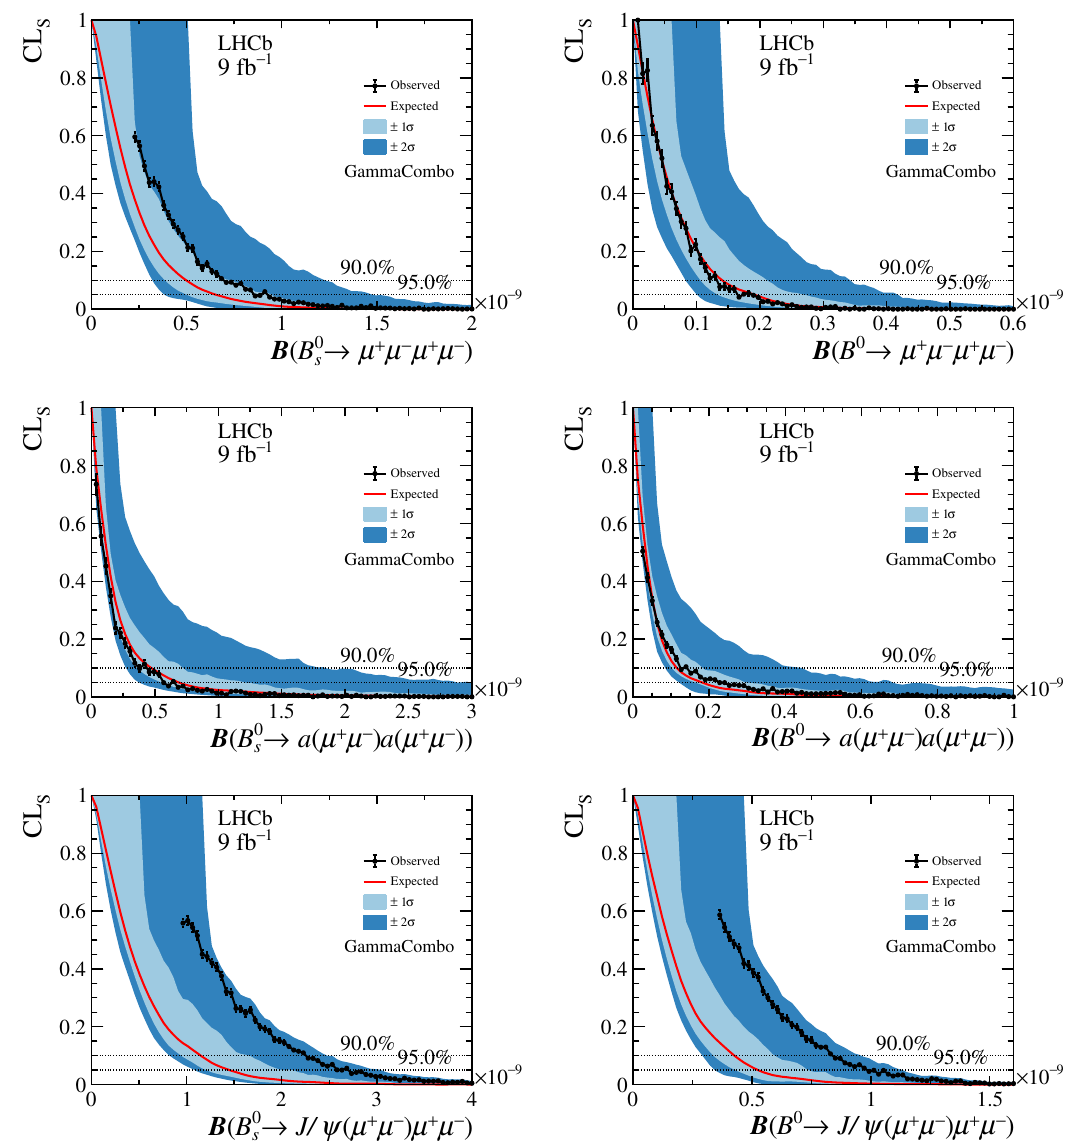
Figure 7 . Confidence levels ( CL s ) obtained from the CL s method to set limits on the branching fractions of (top left) B 0 → µ + µ − µ + µ − , (top right) B 0 → µ + µ − µ + µ − , (mid- s dle left) B 0 → a ( µ + µ − ) a ( µ + µ − ) , (middle right) B 0 → a ( µ + µ − ) a ( µ + µ − ) , (bottom left) s B 0 → J/ψ ( µ + µ − ) µ + µ − and (bottom right) B 0 → J/ψ ( µ + µ − ) µ + µ − s